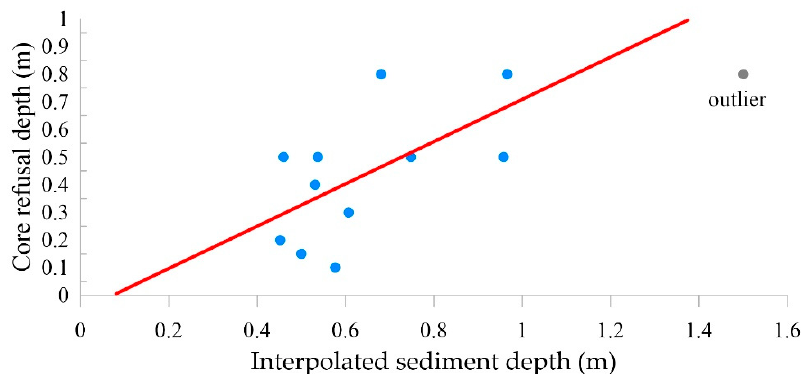
Figure 3. Scatterplot of core sample refusal depth against the initial acoustics point kriging interpolation sediment depths. The furthest sample to the west (greyed out) was removed for refusal (0.8 m) likely not being caused by sediment depth. Trendline = 0.76 × X − 0.06, R 2 = 0.36.